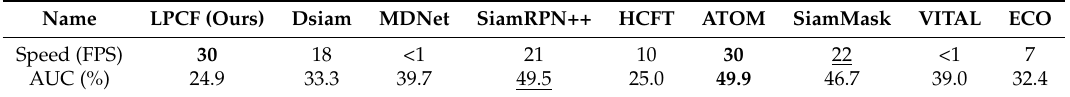
Figure 5. Speed and accuracy plot of state-of-the-art visual trackers on OTB-2015. The proposed LPCF algorithm achieves the best accuracy among all real-time (faster than 25 FPS) trackers. Table 3. Comparison with deep learning-based trackers on the test set of LASOT (280 sequences) in terms of speed and success (AUC). The best results and second highest values are highlighted by bold and